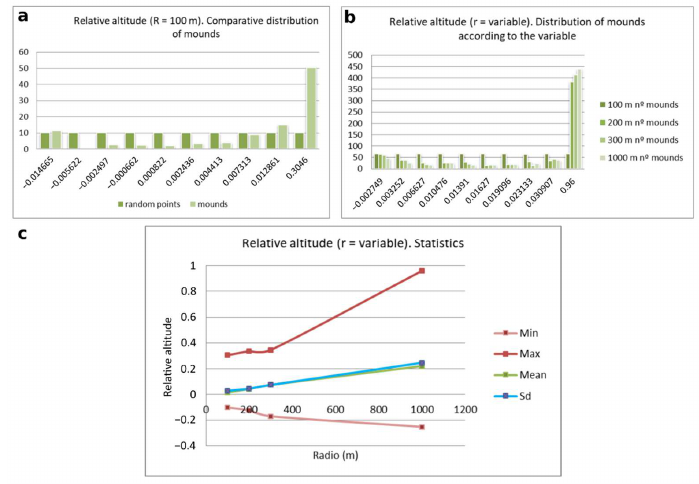
Figure 10. Topographical prominence (relative altitude analysis).